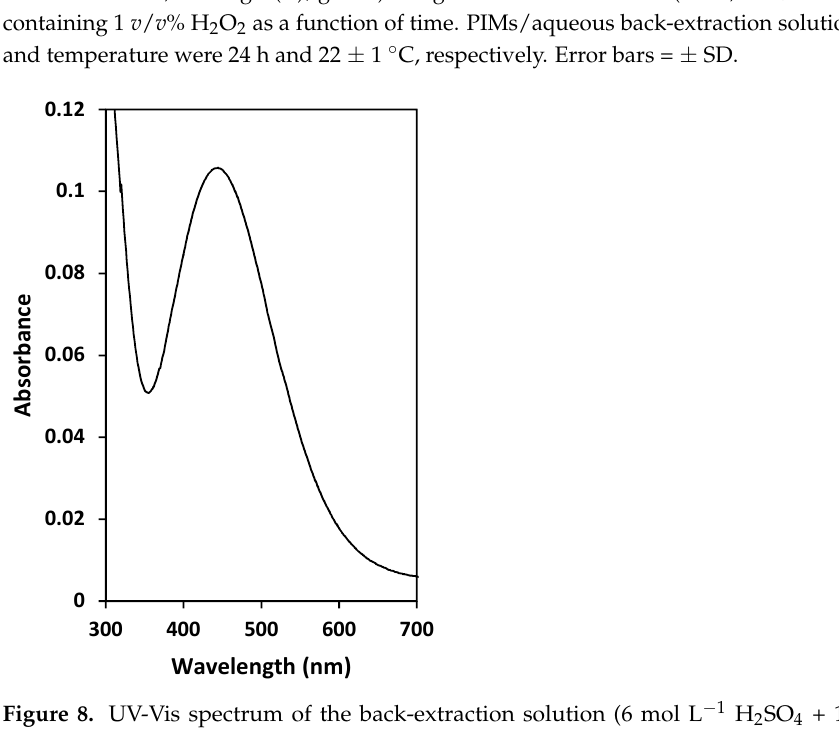
Figure 7. Back-extracted percentage of V(V) from PIMs (50 wt% PVDF-HFP, 40 wt% Aliquat ® 336 and 10 wt% DBP, 33.5 mg V(V)/g PIM) using sulfuric acid solutions (1.0  , 3.0 ○ and 6.0 ▲ mol L −1 ) containing 1 v / v % H 2 O 2 as a function of time. PIMs/aqueous back-extraction solution contact time and temperature were 24 h and 22 ± 1 °C, respectively. Error bars = ± SD.